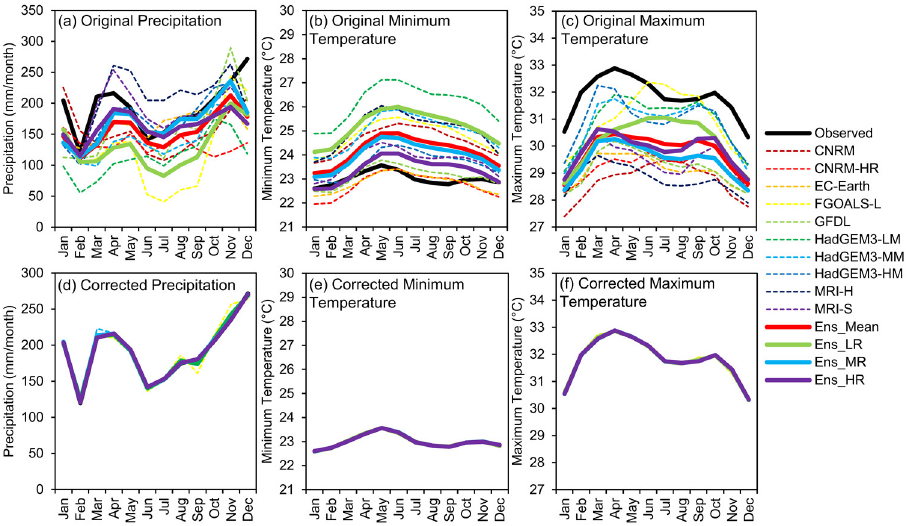
Figure 3. Original and bias corrected monthly mean ( a , d ) precipitation, ( b , e ) minimum temperature and ( c , f ) maximum temperature over the Johor River Basin during the period of 1985 to 2014.